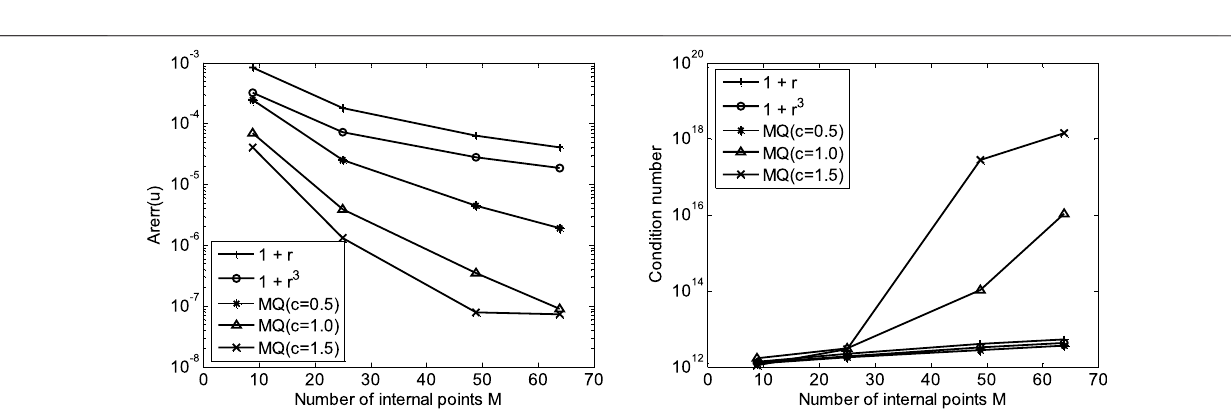
FIGURE 4 | Convergence curves of average relative error and condition number with N = 36 by using different interpolating RBFs.